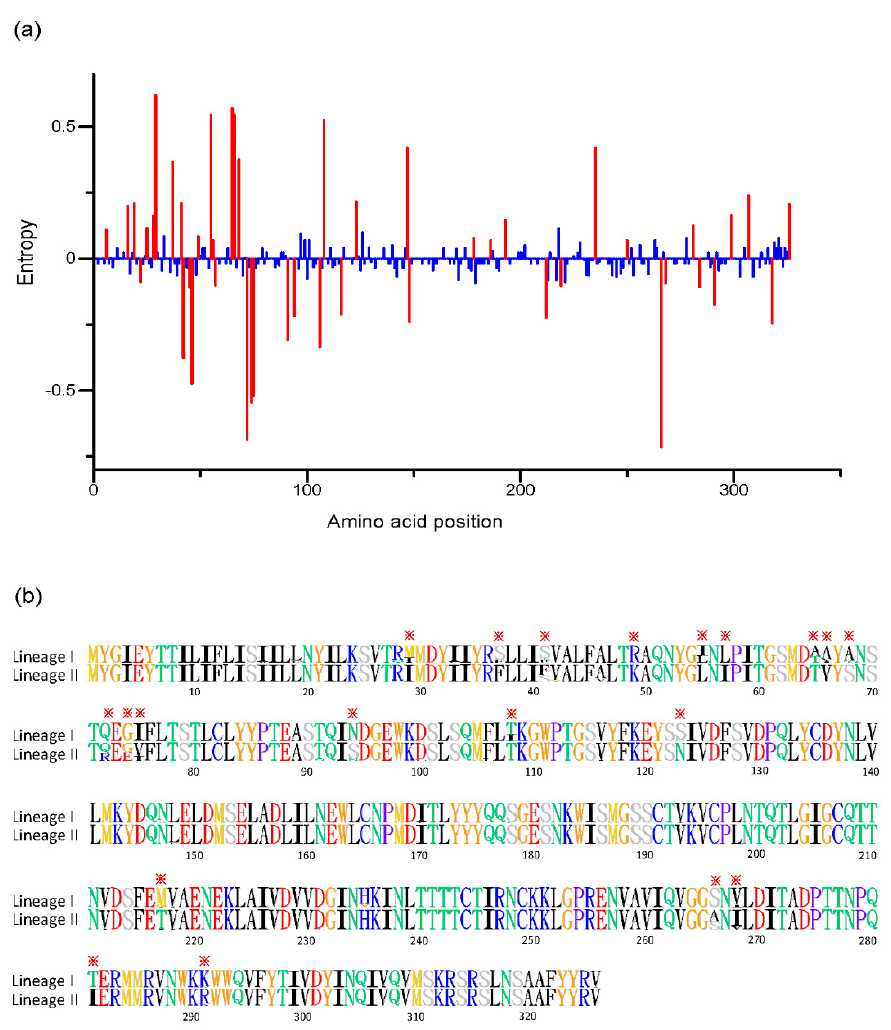
Figure 3. ( a ) Shannon entropy comparison between two lineages with significant di ff erences colored in red. ( b ) Amino acid alignment between two lineages with significant specific amino acid residues labeled with asterisks.